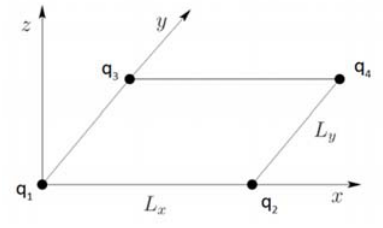
Figure 2. Rectangular segments with four nodes.